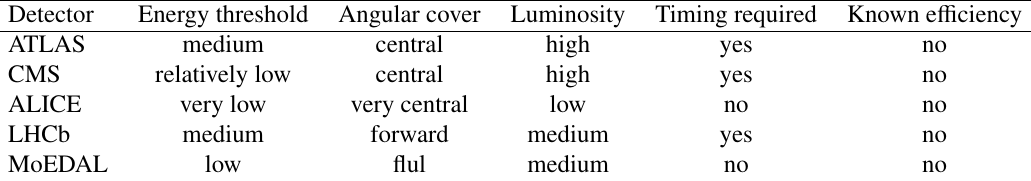
Table 1. Qualitative summary of the advantages / disadvantages of the LHC experiments as detectors of very highly ionizing particles